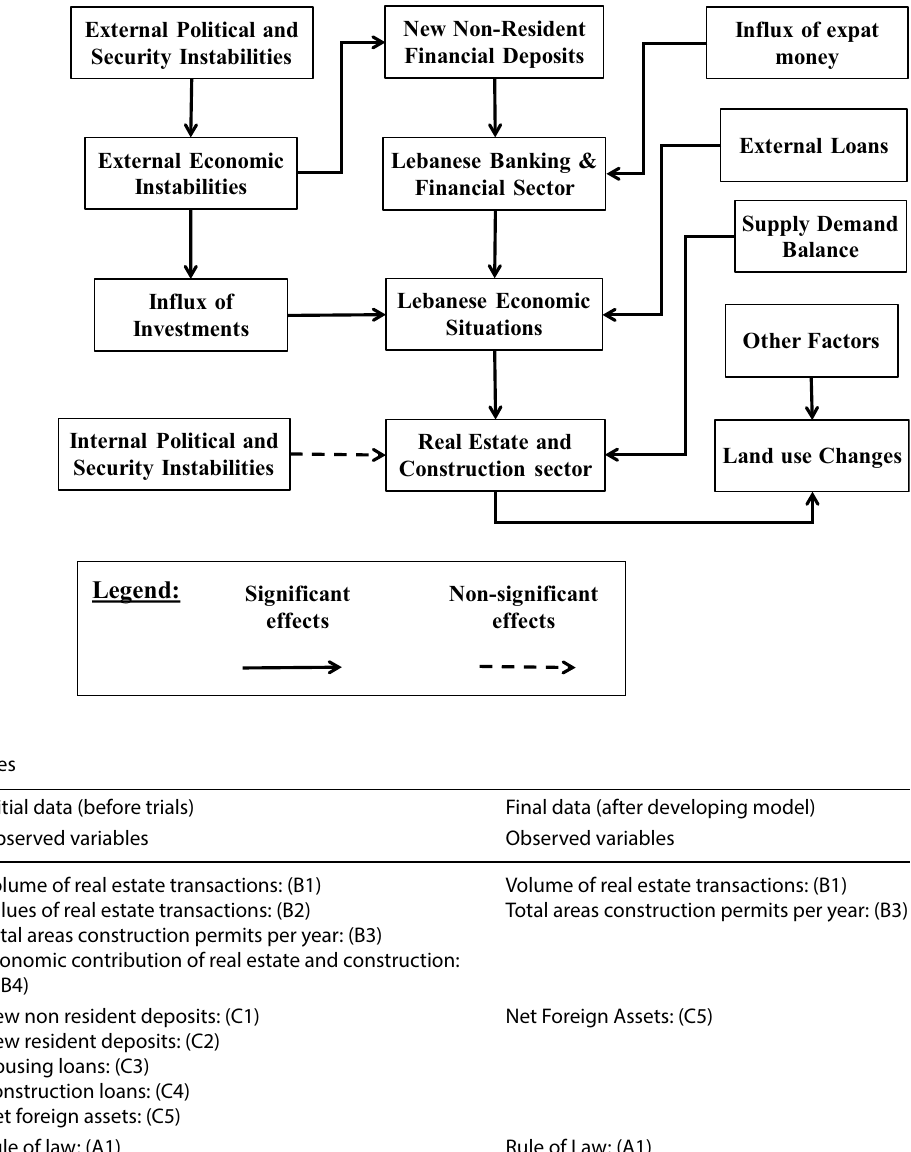
Fig. 7 Potential factors affect- ing the real estate and urban development